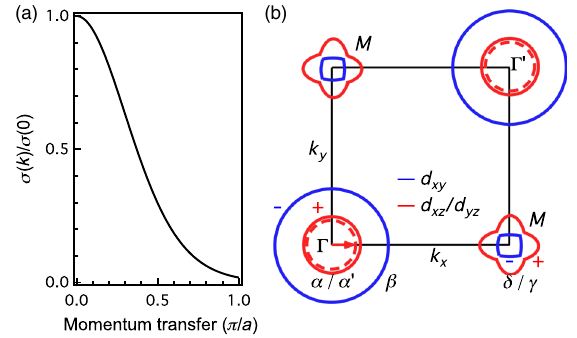
FIG. 5. (a) Calculated scattering strength as a function of momentum transfer (see the text). (b) Schematic FS of Ba 0 K 0 Fe 2 As 2 , with the FS sheets drawn in red and blue . 6 . 4 having opposite SC-gap-phase